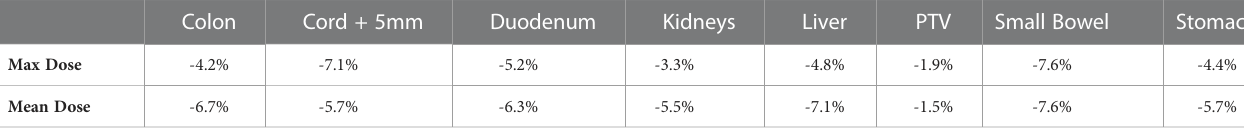
TABLE 1 Average max and mean dose percent difference (ground truth – predicted) of replans.